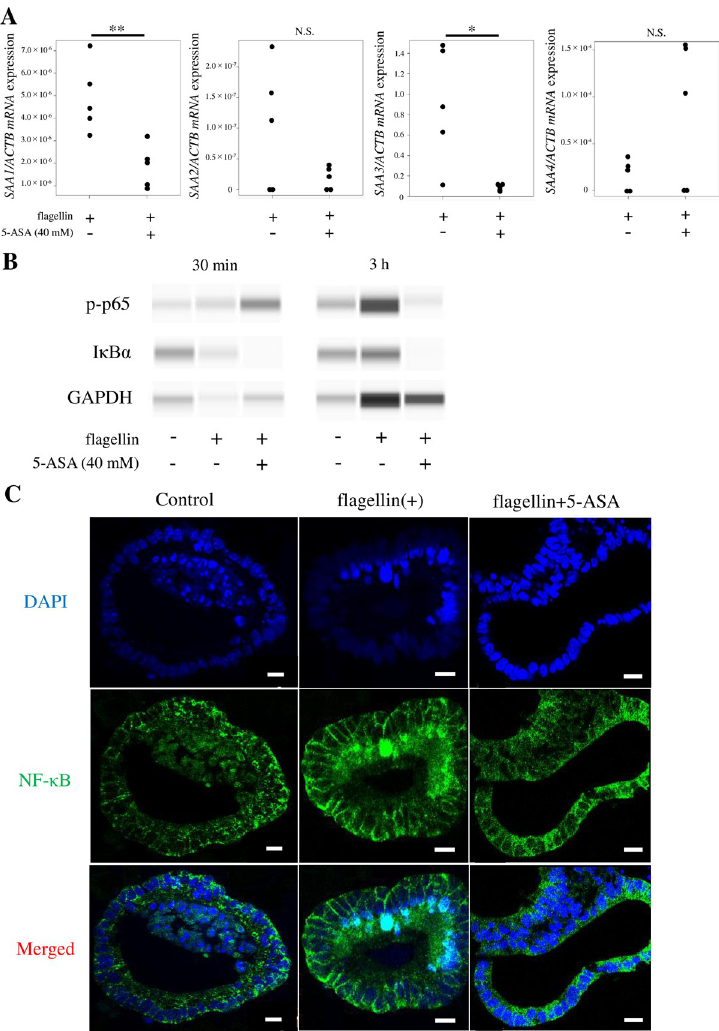
Fig 4. 5-Aminosalicylic acid (5-ASA) suppresses SAA1-4 expression via NF- κ B in small intestinal organoids. ( A ) Normalized SAA expression levels in small intestinal organoids upon stimulation with flagellin alone (10 μ g/mL) or plus 5-ASA (40 mM) after 3 h. SAA1/3 was suppressed by the addition of 5-ASA. SAA expression level was normalized to that of ACTB and is represented as the mean ± standard deviation (n = 5). �� P < 0.01, � P < 0.05. ( B ) Small intestinal organoids were stimulated with flagellin at 30 min and 3 h with and without 5-ASA. The protein expression levels of phosphorylated-p65 and I κ B were examined by SimpleWestern TM . The protein degradation of I κ B was observed after 30 min of flagellin stimulation of small intestinal organoids, and the protein expression of I κ B α was also repressed by 5-ASA. The inhibition of p65 phosphorylation by 5-ASA was not apparent at 30 min but clear 3 h after flagellin stimulation. This experiment was performed twice independently, and similar results were obtained. A scan of the original untrimmed gel image is displayed in S2 Fig. ( C ) Flagellin promotes activation of the NF- κ B pathway, as observed by immunostaining data showing translocation of NF- κ B into the nucleus. Immunofluorescence confirmed that NF- κ B translocation into the nucleus was inhibited with the addition of 5-ASA. Each negative control was photographed under the same conditions (exposure time, etc.) to confirm the absence of autofluorescence. Scale bar: 10 μ